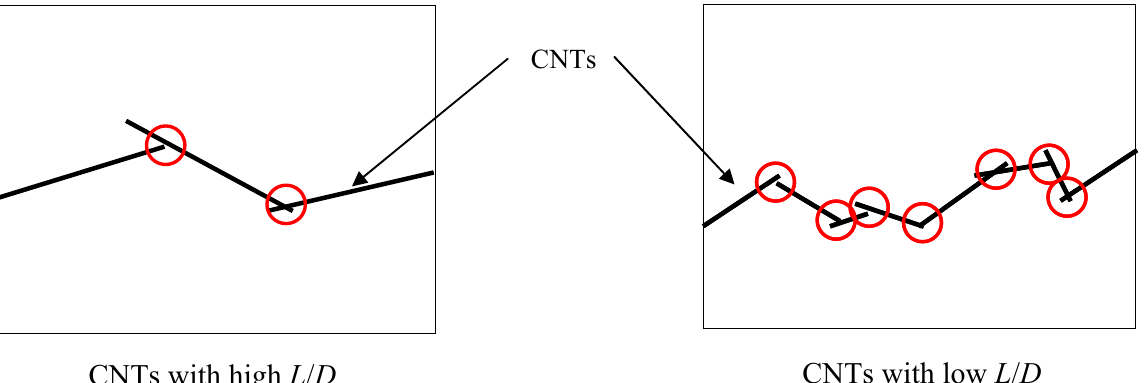
Figure 20. Influence of aspect ratio of fillers on conductive